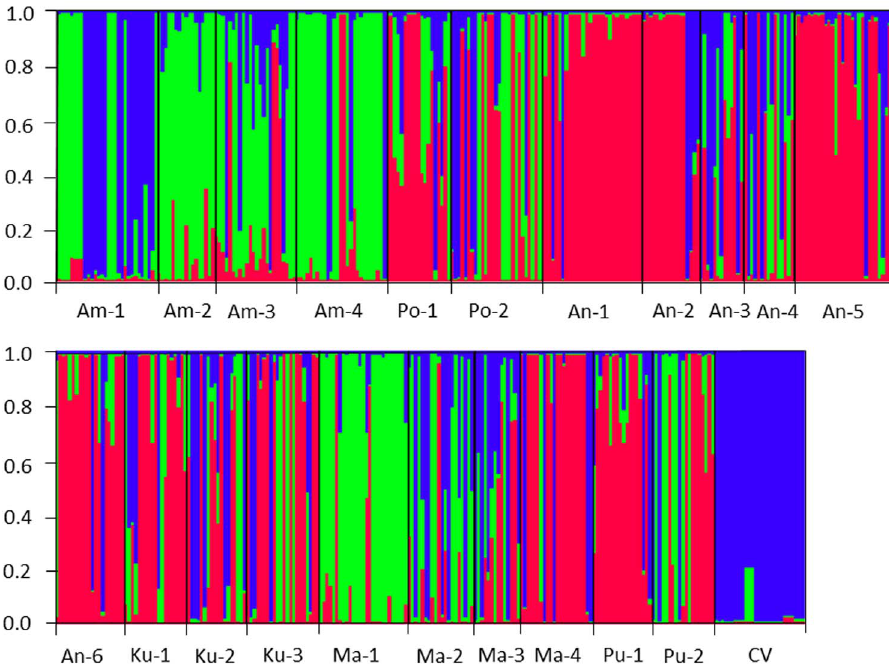
Figure 4. Genetic relationships of 21 weedy rice populations (Am-1 to Pu-2) and rice varieties (CV) from STRUCTURE analysis. Each individual is represented by a vertical bar assigned into three colors, with height proportional to each of the three inferred genetic components. The numbers beside vertical axis represent probability of assignment.